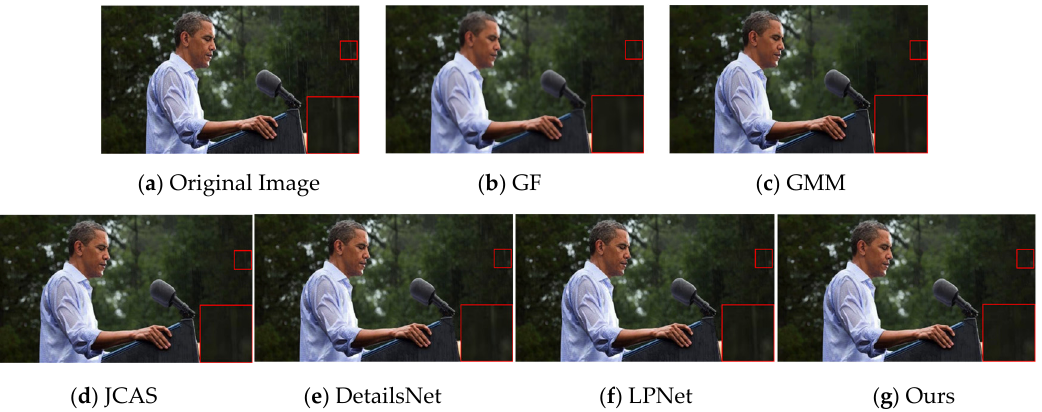
Figure 9. The subjective visual effects of real image (“Obama”) are compared in total. The first image is the input image, and the following images are the results of GF, GMM, JCAS, DetailsNet, LPNet, and our method.